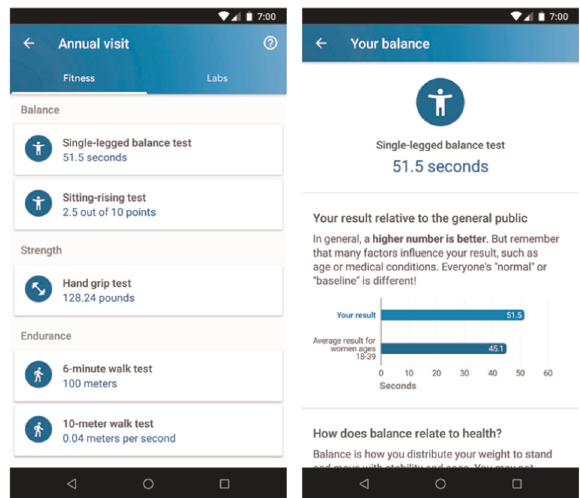
Fig. 2 Results display. Results of physical performance testing are returned through the Project Baseline Mobile app. Results of each test are enhanced with contextual information including a descrip- tion of the study procedure, normative data, and links to additional resources from both the lay and scienti fi c communities.